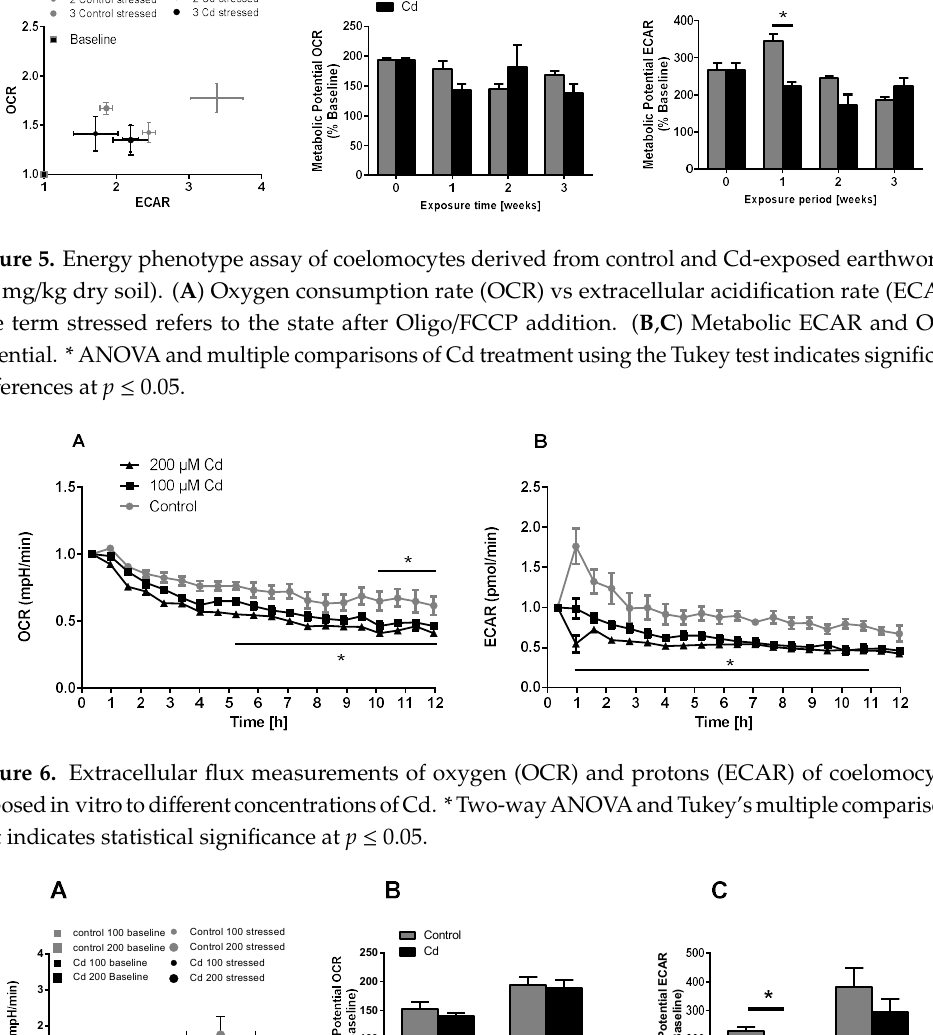
Figure 8. Mito stress test of coelomocytes. ( A ) OCR of coelomocytes including an acute injection of 200 µM CdCl2 indicated by the arrow. ( B ) Mito stress test parameters. ANOVA did not detect any significant differences. 3. Discussion The present study focuses on coelomocytes to study the response to Cd on the innate immune system and energy metabolism. It is already known that the heavy metal Cd affects the immune system, but the actual biochemical and physiological mechanisms of these effects are largely unexplored. A proteomics approach identified several proteins related to immunity, confirming the effect on the immune system, and revealing a slight down-regulation when earthworms were exposed to Cd for two weeks. In contrast, proteins involved in energy metabolism showed a Cd- dependent increase. We suggest that higher levels of PDH and NADH dehydrogenase hint towards